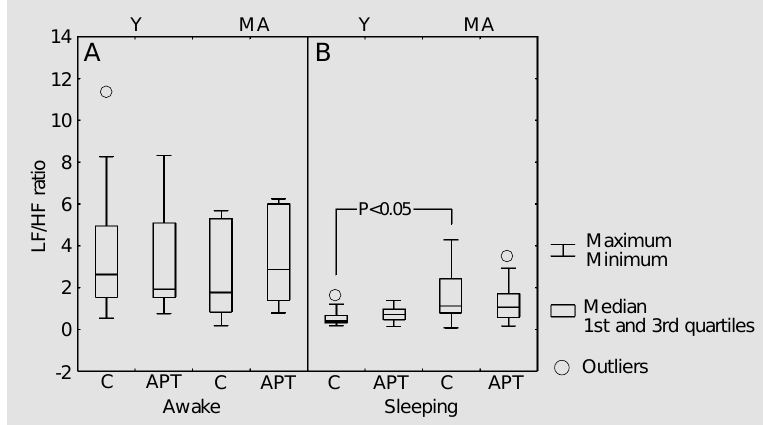
Figure 2. Ratio of the low versus high frequency power spectral components (LF/HF ratio), obtained during awake (A) and sleeping (B) conditions, in the young (Y) and middle-aged (MA) groups, during control (C) conditions and after aerobic physical training (APT). Data are reported as box-plots. P<0.05 obtained by the Mann-Whitney